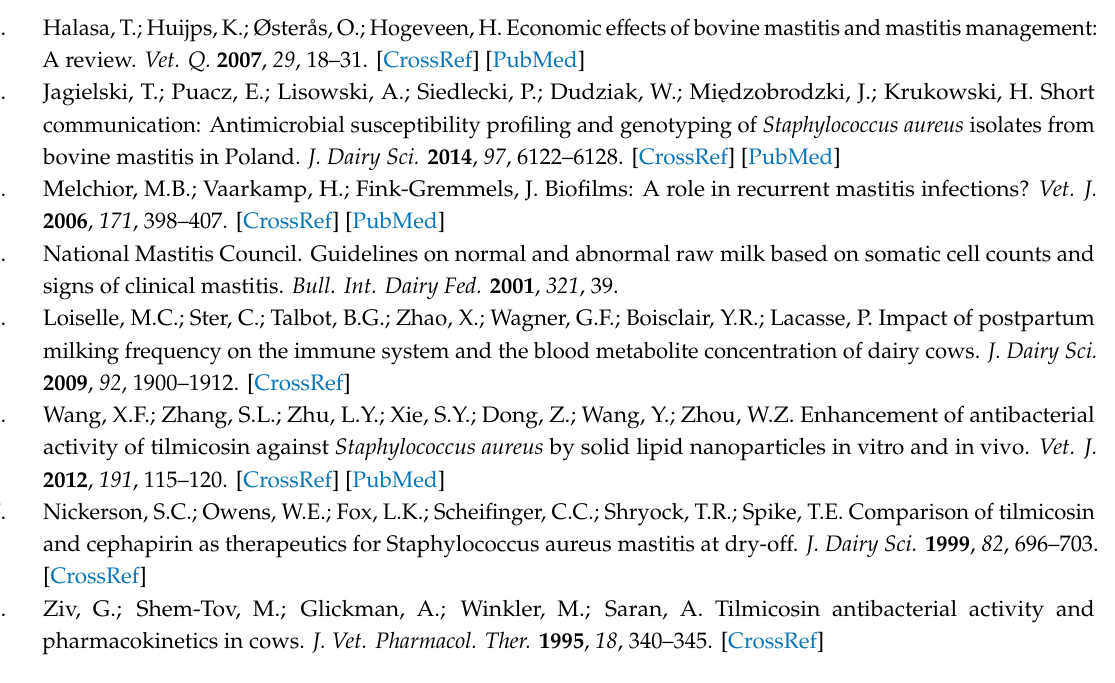
Table S1: Factors and levels of the L9 (3 4 ) orthogonal design, Table S2: The optimization of emulsifier by orthogonal experiment (L 9 3 4